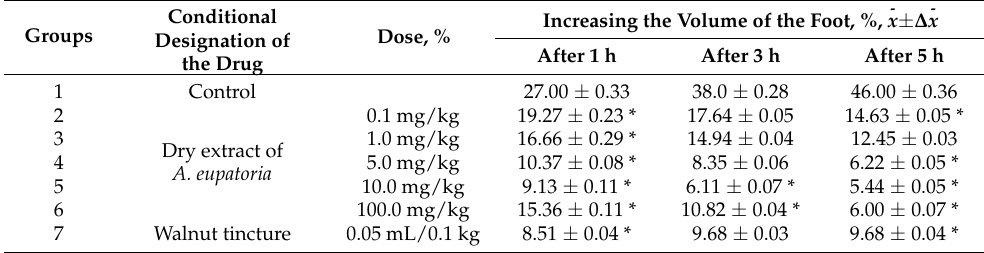
Table 4. The effect of the herb extract of A. eupatoria on the development of limb swelling in rats. Groups